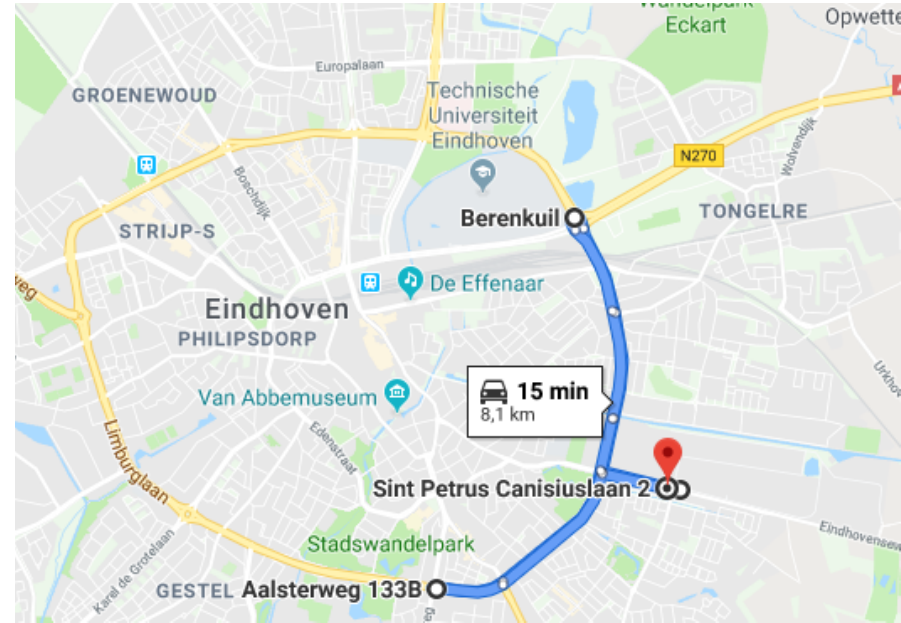
Figure 4. The road segment near Eindhoven in the Netherlands, used for tests on a DAF hybrid